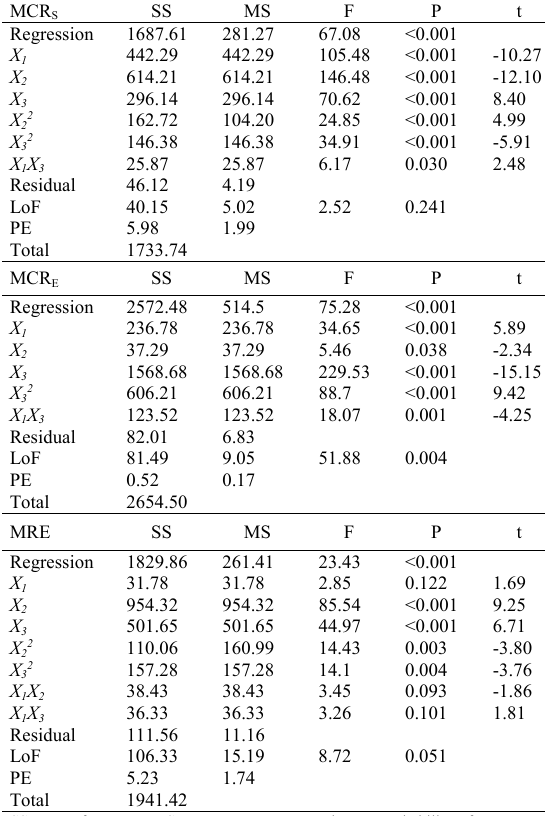
Table 4: The results of ANOVA